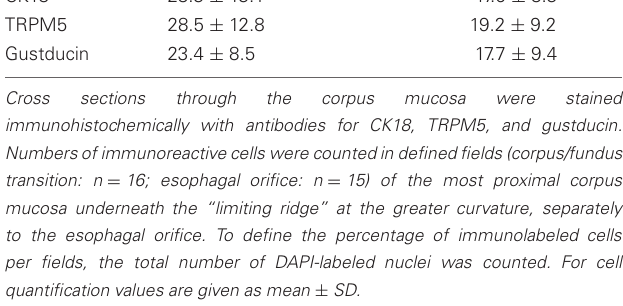
(A) is reminiscent of the labeling pattern obtainedwith thegustducinantibody (B) . Overlay (C) of (A) and (B) showsthat asubpopulationofcells expressboth gustducinand GFP. (D–F) Consecutivesectionsto that shownin (A–C) stained with the TRPM5 antibody( red ).TRPM5-immunoreactivityrevealsa cluster of cells (E) resemblingthatofPLC β 2-GFP-expressingcells (D) ,inbothmorphology andposition, respectively. Overlay (F) of (D) and (E) indicatesa complete overlapofGFPandTRPM5inasubpopulationofcorpusmucosalcells.Sections werecounterstainedwith DAPI ( blue ). Scale bars : ( A–F ) = 20 μ m.